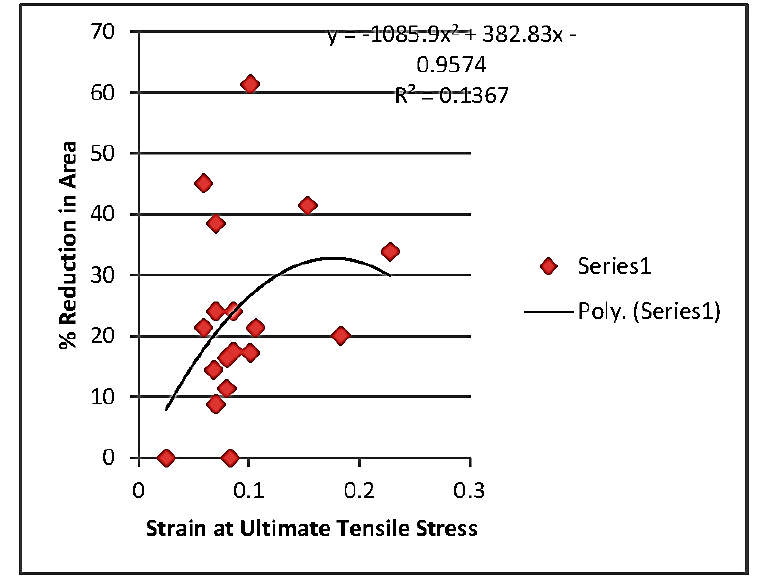
Figure 5. Percent reduction in area versus strain at ultimate tensile strength [15].